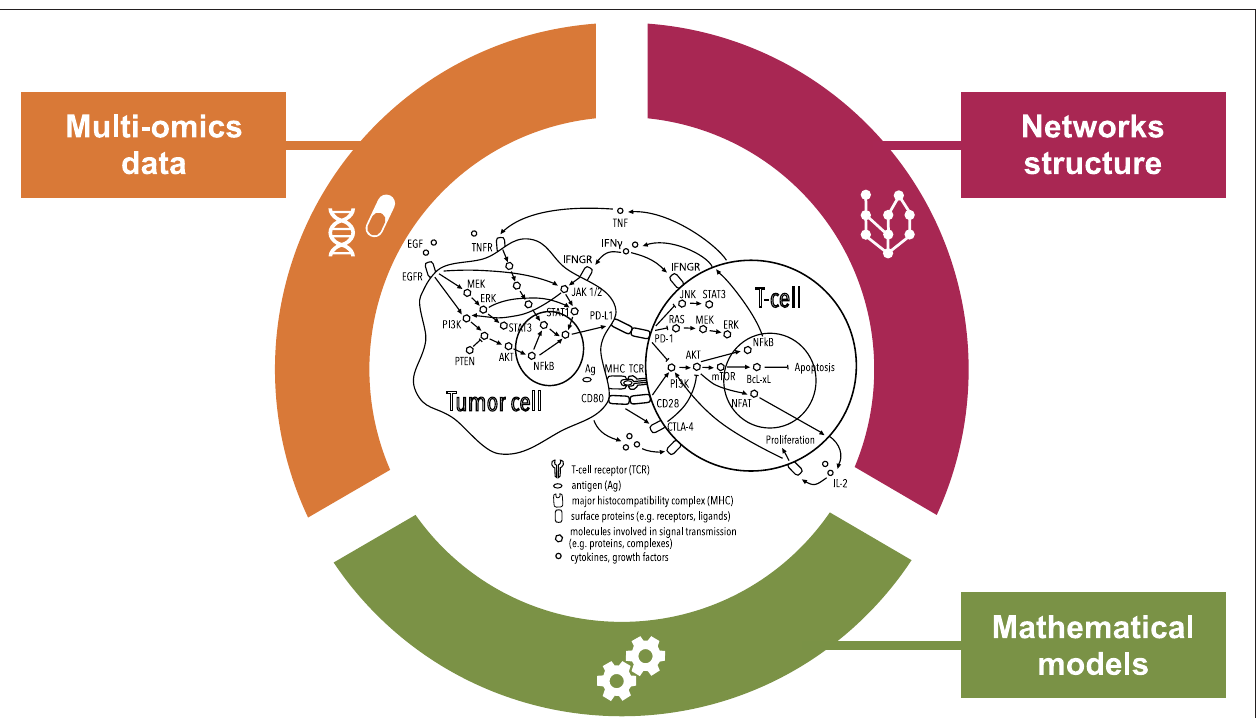
FIGURE 2 | Comprehensive inspection of the tumor microenvironment (TME) from multiple angles. This illustration shows how systems medicine approaches are key to improving our understanding of the mechanisms of resistance to immunotherapies with checkpoint blockers (ICBs). Combining multi-omics data and prior knowledge information on inter- and intra-cellular pathways using mathematical models allows encompassing the complexity of the TME paving the way for the discovery of systems-based biomarkers of the response to